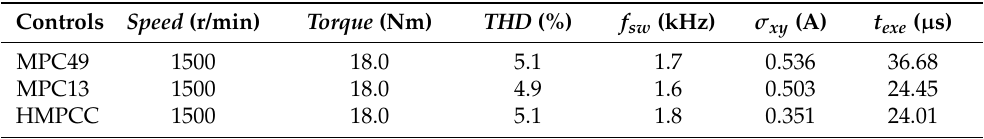
Table A4. Summary of the performance indicators for the control strategies applied to the asymmet- rical six-phase IM (Test